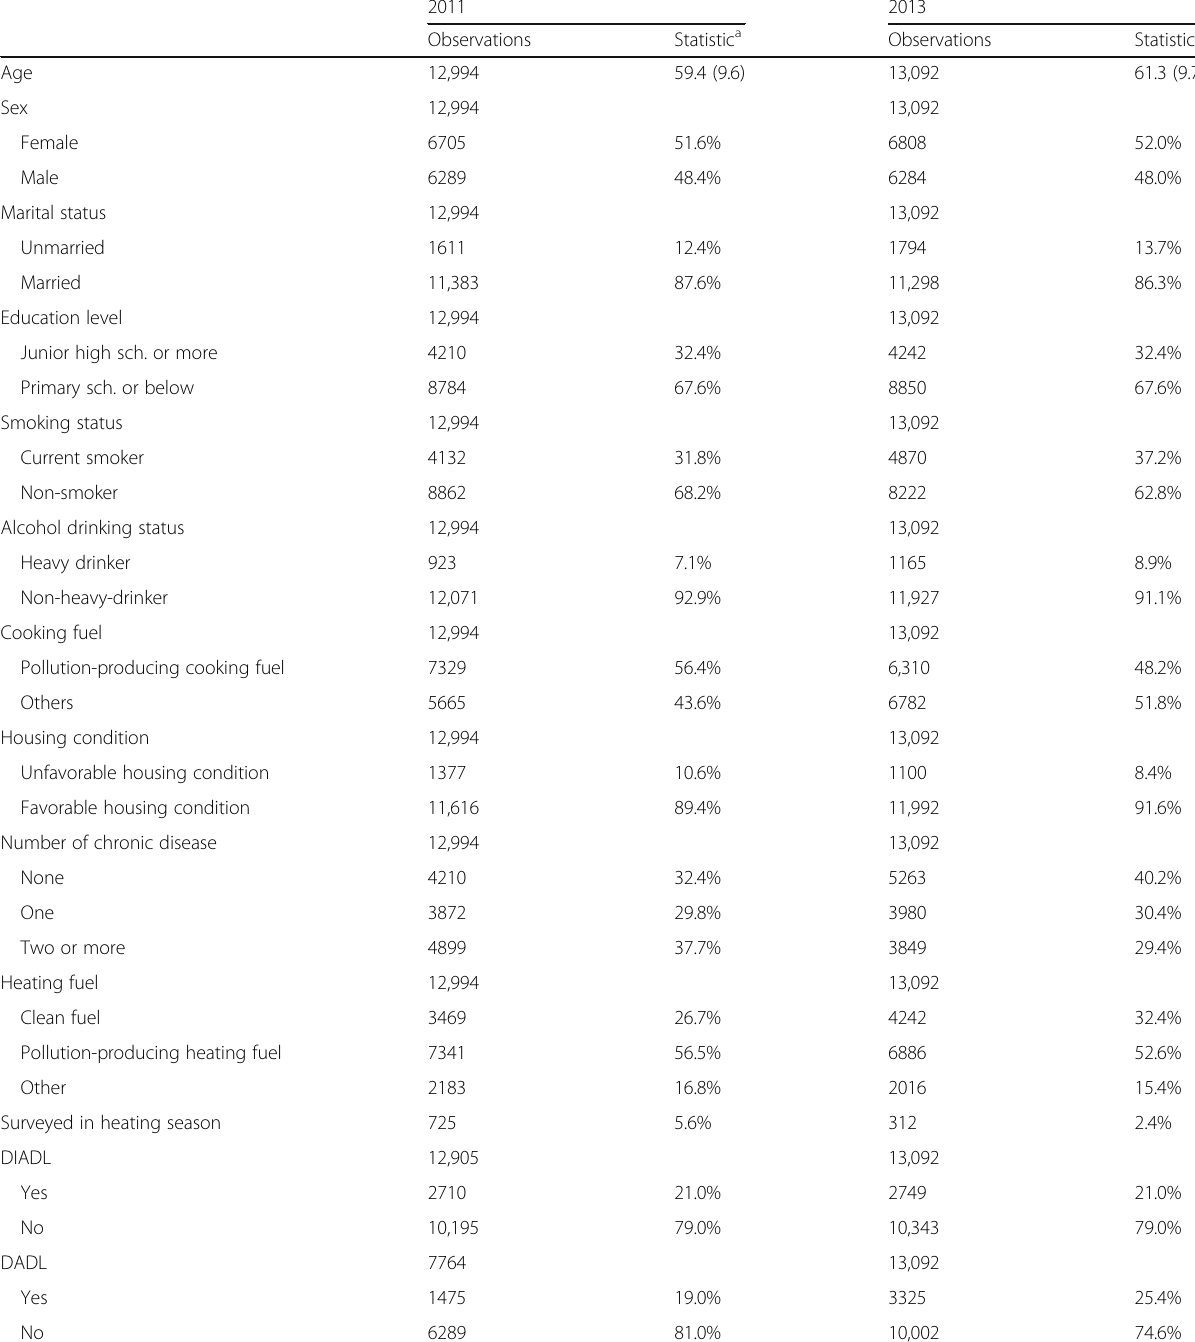
Table 1 Characteristics of the CHARLS participants 2011 2013 Observations Statistic a